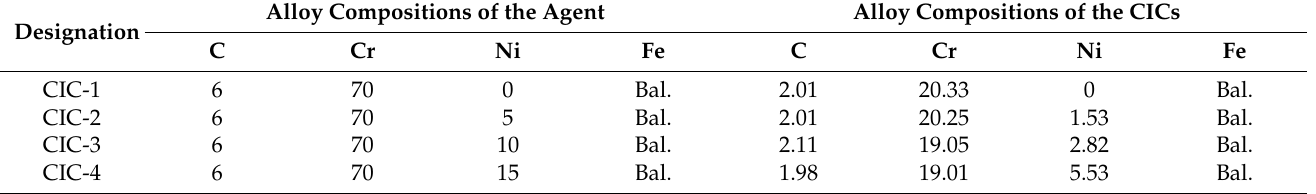
Table 1. Alloy compositions designed for casting infiltration agents and determined in the obtained CICs